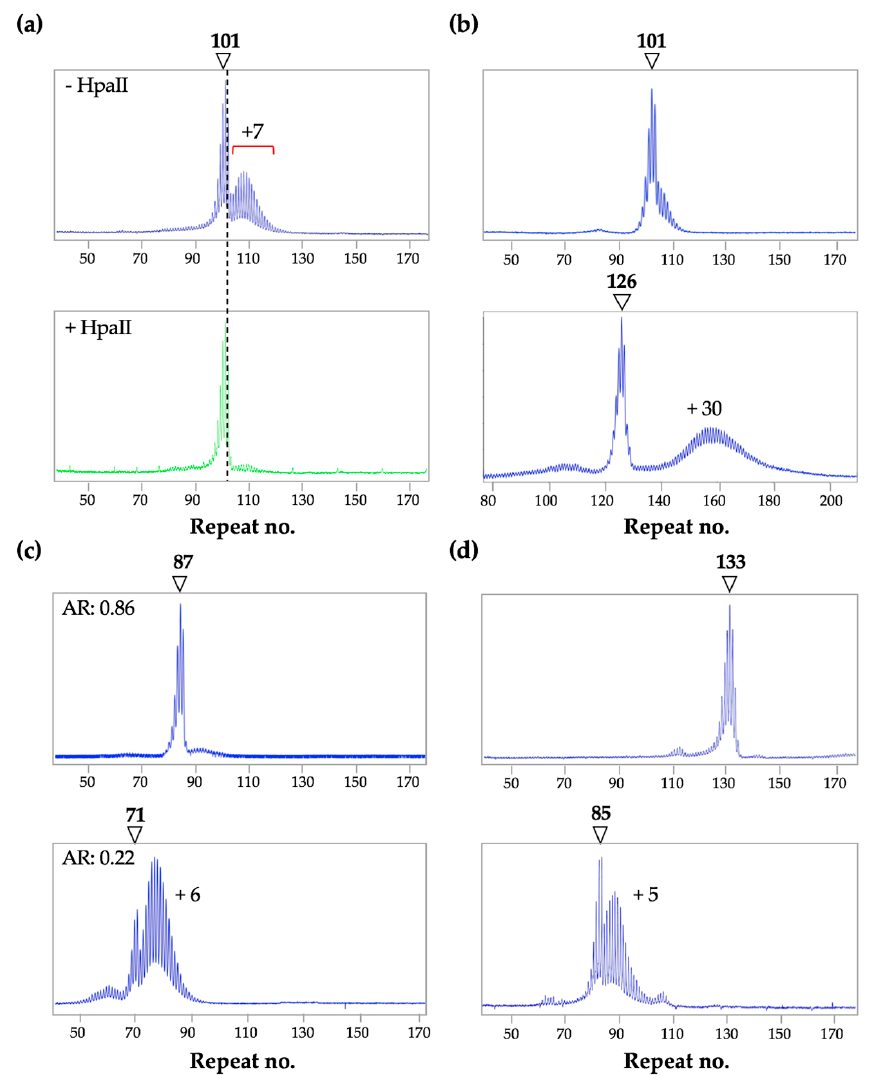
Figure 4. PM Repeat PCR profiles from the blood of human female PM carriers. The arrow in each instance indicates the stable allele with the indicated number of repeats. ( a ) Profiles for a female PM carrier without (top panel) and with (bottom panel) HpaII pre-digestion were generated as previously described [16]. The alleles on both the active and inactive X are shown in blue in the top panel and the alleles on the inactive X in green in the bottom panel; ( b ) Examples of very different bimodal PCR profiles; ( c ) Profiles for 2 women with different activation ratios (ARs); ( d ) Profiles of two females of similar ages and ARs, both with no AGG interruptions showing very different levels of somatic